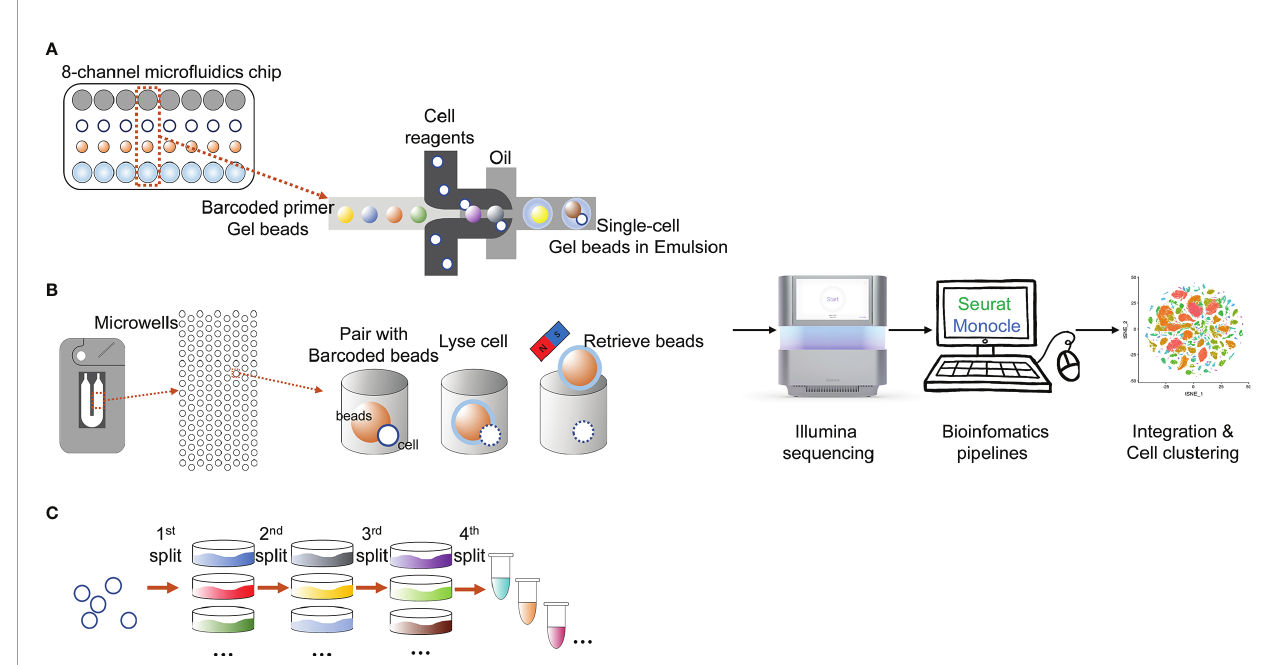
FIGURE 2 | State-of-the-art cell isolation methods and the main procedures of different scRNA-seq technologies. (A) micro fl uids; (B) microchips; (C)